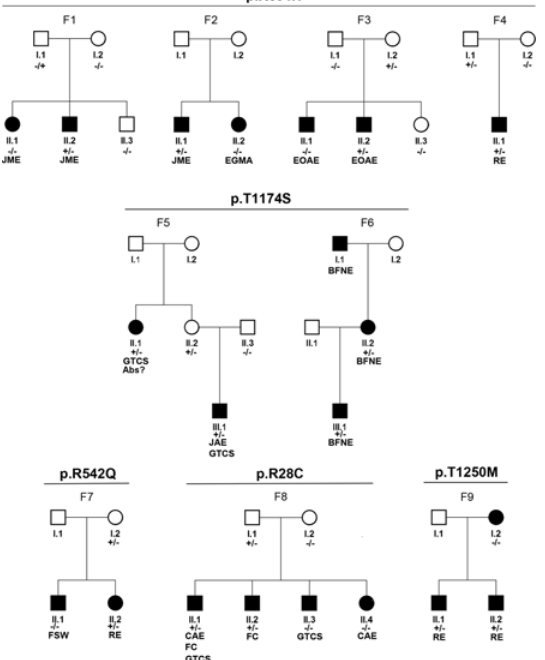
Fig 1. Segregation analysis of the identified variants. Analysis of likely segregation of the respective mutations in family members could be performed in eleven families. Accession is according to reference transcript NM_001165963.1; and references protein NP_001159435.1. Abbreviations: FC = febrile convulsion; JME = juvenile myoclonic epilepsy, CAE: childhood absence epilepsy, JAE: juvenile absence epilepsy, EGMA: epilepsy with generalized tonic-clonic seizures predominantly on awakening, EOAE = Early onset absence epilepsy, RE = Rolandic epilepsy, Abs = absence, BFNE = Benign familial neonatal seizure, FSW = Focal Sharp Waves, GTCS = Generalized tonic-clonic seizure